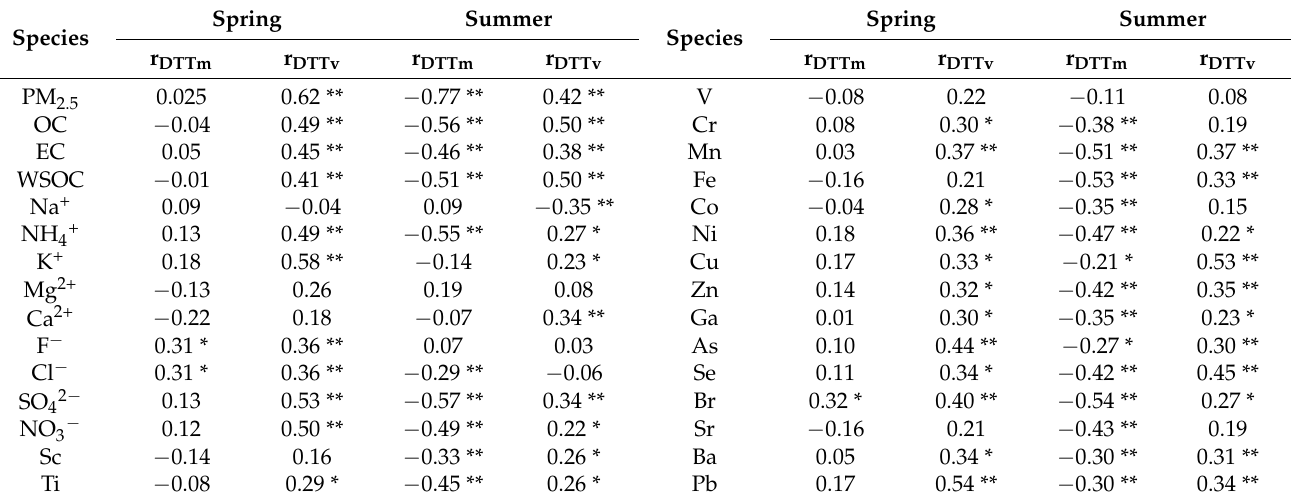
Table 3. A summary of correlation coefficients (Pearson’s r ) between DTT activity and chemical components in PM